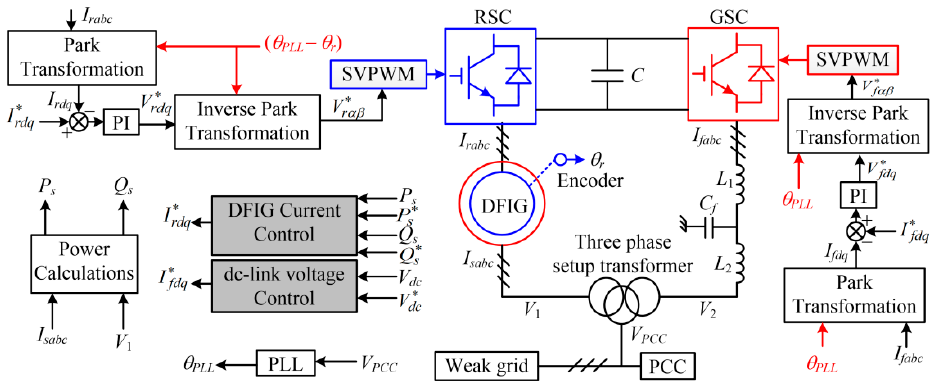
Figure 1. Schematic diagram of the studied doubly fed induction generator (DFIG) system.